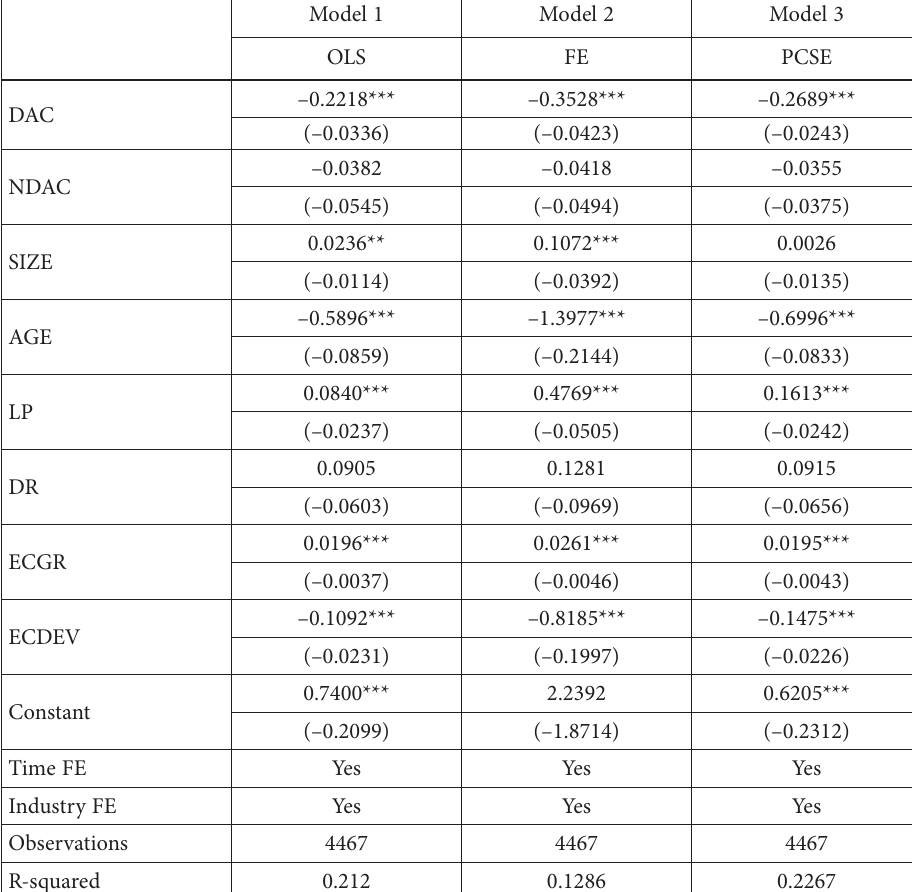
Table 6. Empirical results for the whole period